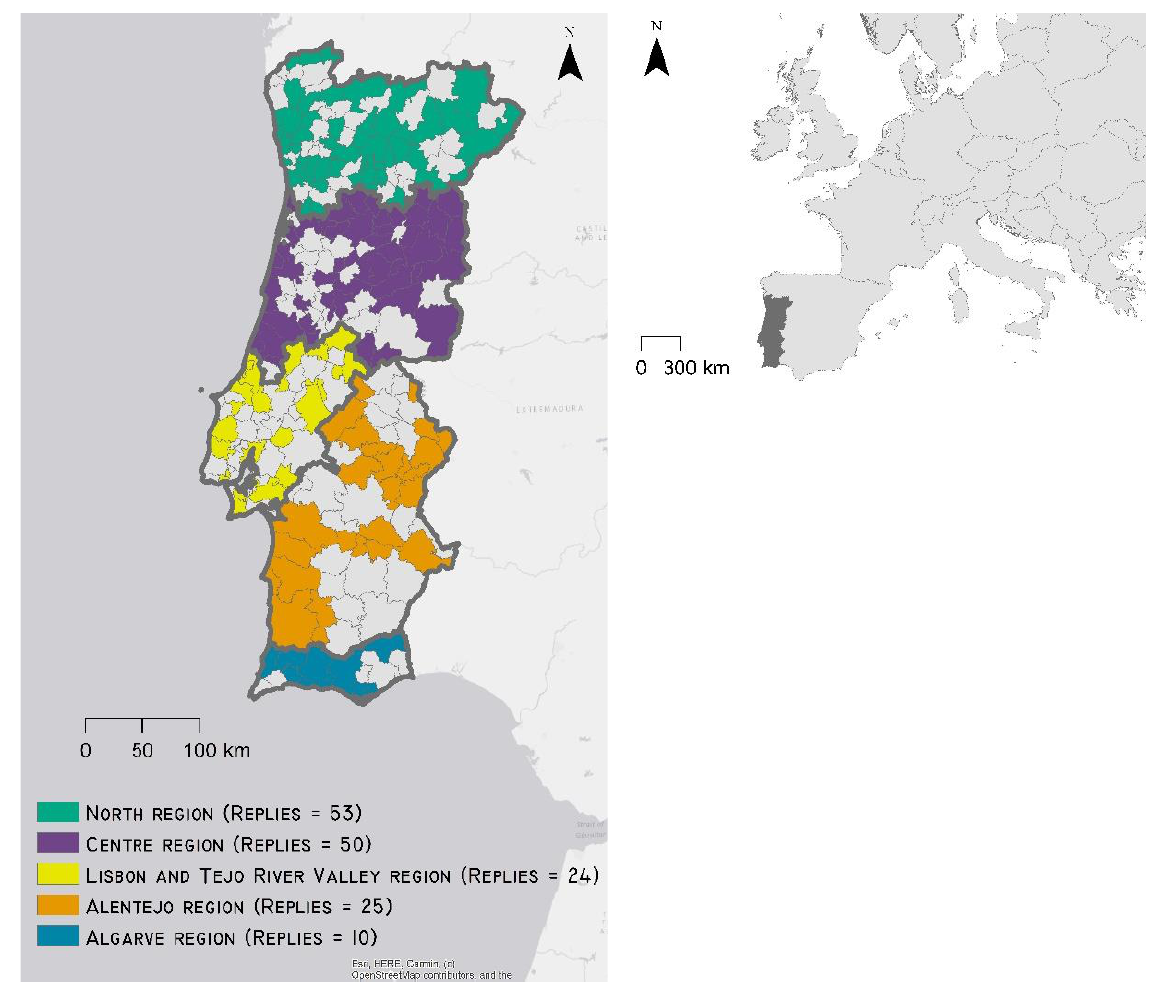
Figure 1. Municipalities that responded to the online survey per IMSRF region (175 municipalities replied, but 13 chose to remain anonymous).